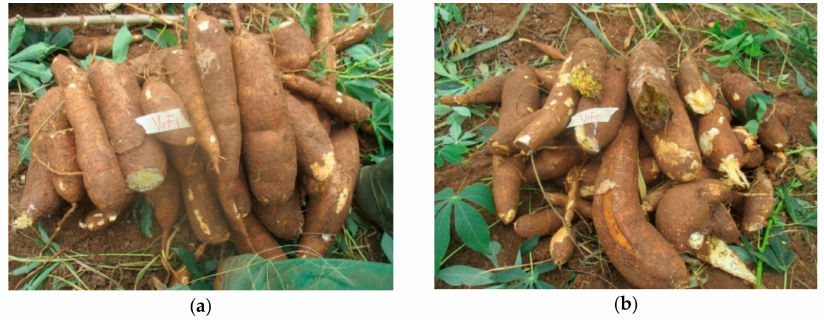
Figure 2. Storage roots of treated and untreated biofortified cassava cultivar IITA-TMS- IBA011368 at 12 months after planting; ( a ) treated with 3G Carbofuran; ( b ) untreated storage